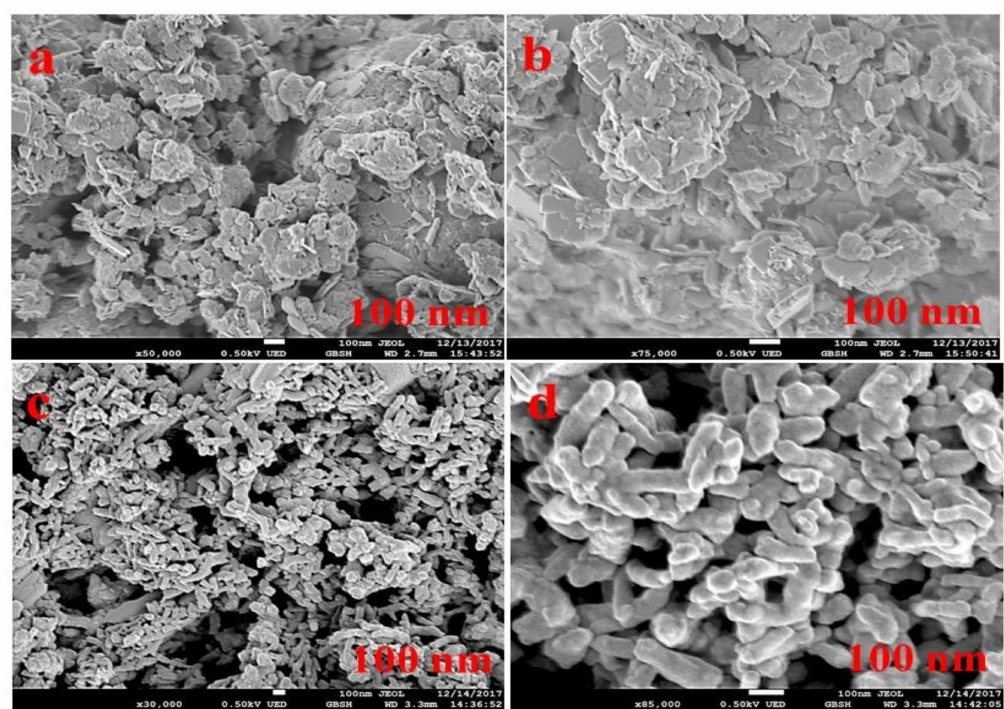
Figure 1. FESEM images of ( a , b ) WS 2 nanoflakes, ( c ) PANI nanotubes, ( d ) WS 2 -PANI granular